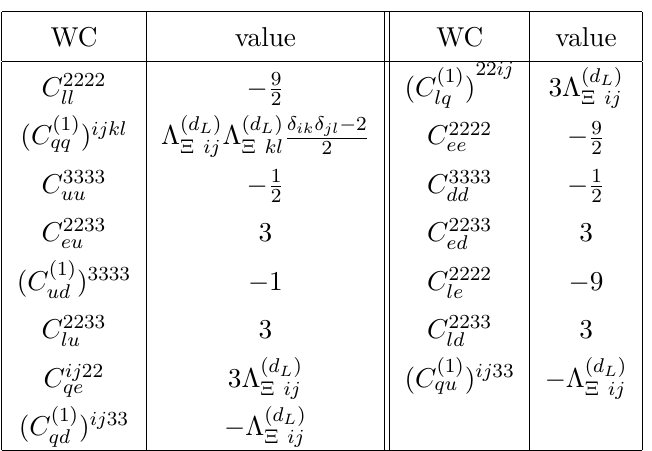
Table 3 . Non-zero tree-level dimension-6 SMEFT WCs predicted by integrating out the S 3 in our benchmark model (2.10), in units of λ 2 , in the Warsaw basis [96]. Here the EFT matching scale is Λ = M S . 3